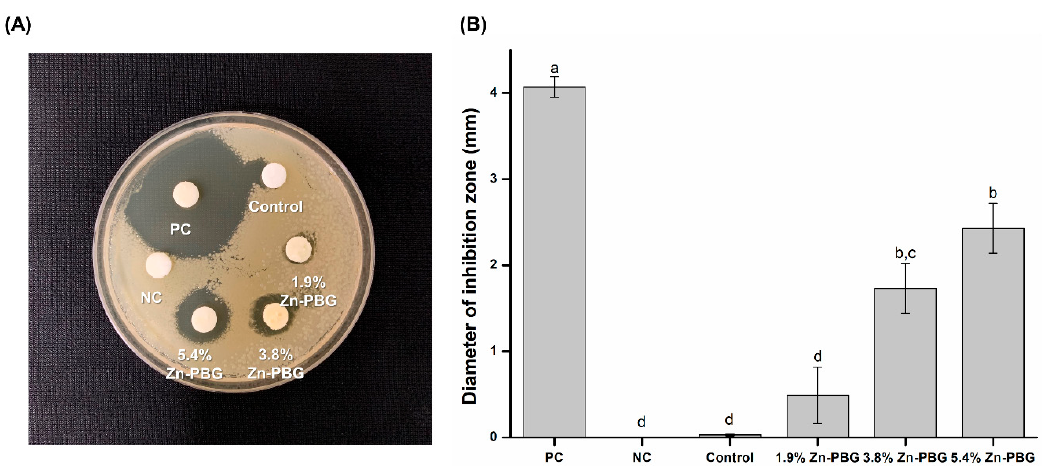
Figure 5. Antibacterial properties: ( A ) Photograph of inhibition zone test and ( B ) diameters of zones of inhibition on agar plates.